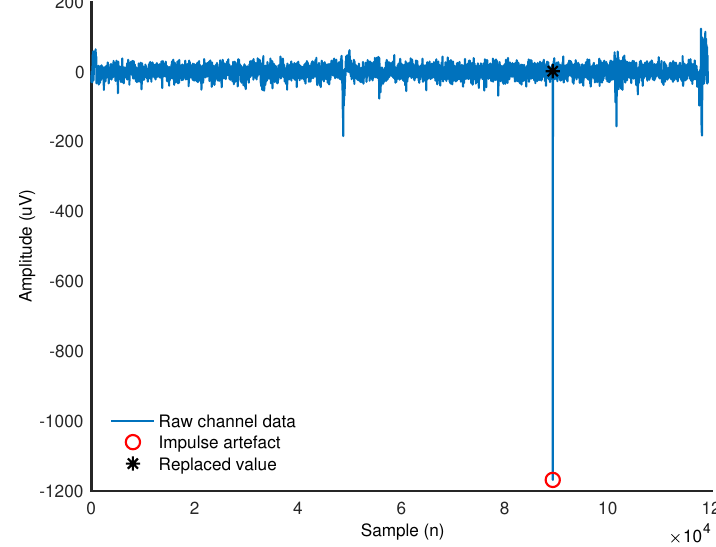
Figure 1. An example of the artefact detected in the prototype